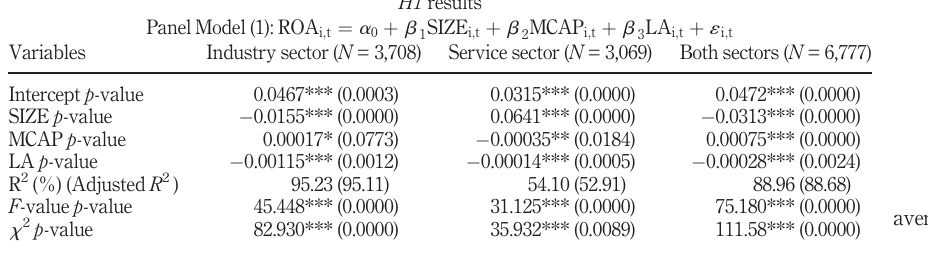
Table IV. Impact of